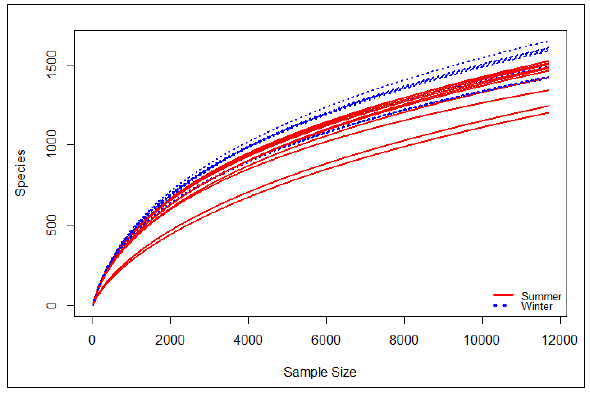
Rarefaction curve of bacterial diversity (operational taxonomic units) in Zulu sheep faeces across winter and summer. Rarefaction curve was constructed using the vegan package of R software.